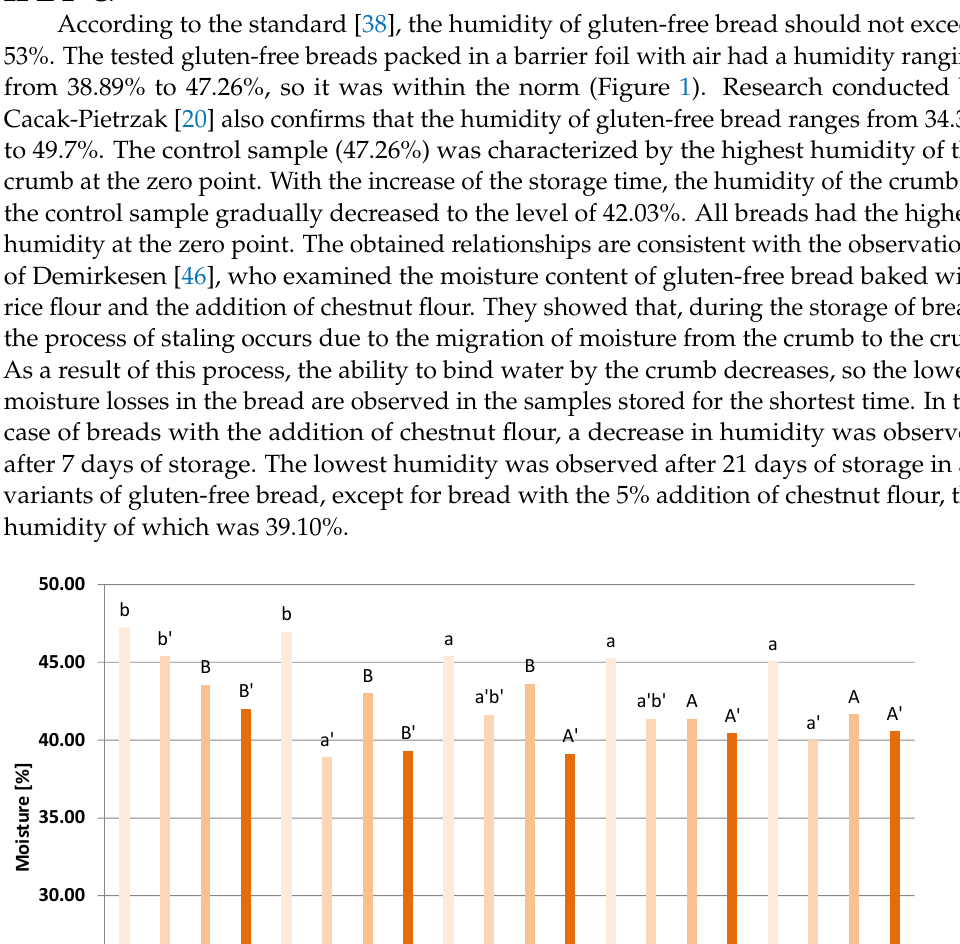
Figure 2. Moisture of the crumb of gluten-free breads with the addition of chestnut flour in the amount of 5% (5CF), 10% (10CF), 15% (15CF) and 20% (20CF) after 7, 14 and 21 days of storage, packed in a barrier film with a vacuum. Values marked with the same symbols mean no statisti- cally significant differences (α = 0.05). Comparing the method of packing the tested breads, higher humidity was observed in the case of the breads with the 5, 10 and 20% addition of chestnut flour, vacu- um-packed, after 7 days of storage. The control sample and the bread with 15% addition